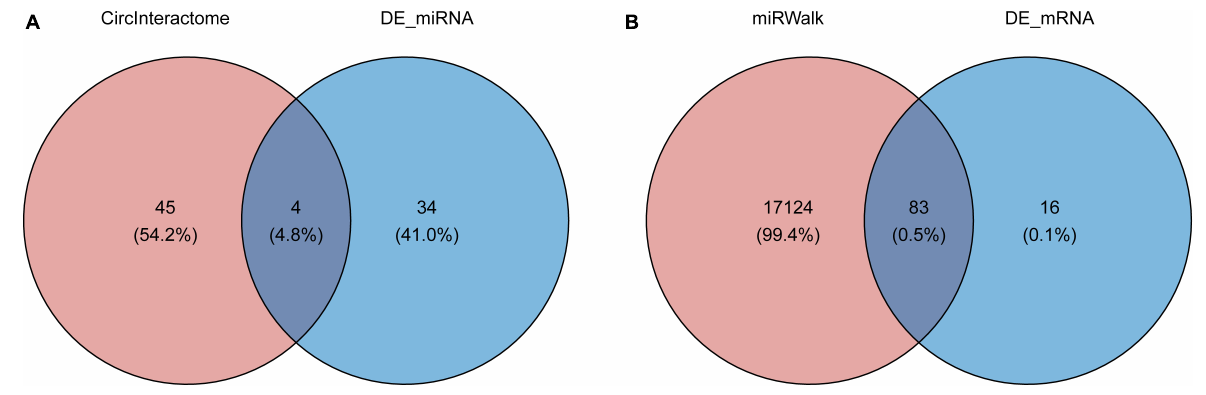
FIGURE 2 | Prediction of circRNA-miRNA and miRNA-mRNA interactions. (A) The Venn diagram of 49 target miRNAs of circRNAs and 38 differentially expressed miRNAs screened from the GSE28954 dataset. (B) The Venn diagram of common target genes of the miRNAs was predicted by the miRWalk database and GSE115574